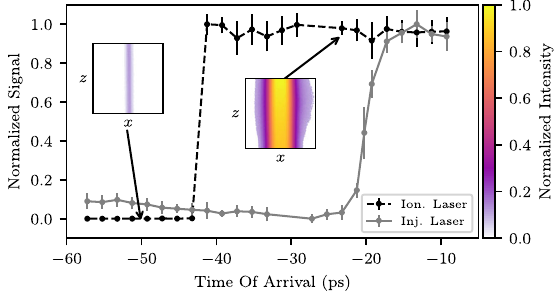
FIG. 7. Normalized integrated plasma-afterglow signal as a function of the time-of-arrival (TOA) between the drive beam and the ionization (Ion.) and injection (Inj.) lasers; t ¼ 0 is defined as the TOA of the electron beam. Inset are examples of the signal enhancement due to electron-beam-induced heating of the plasma formed by the ionization